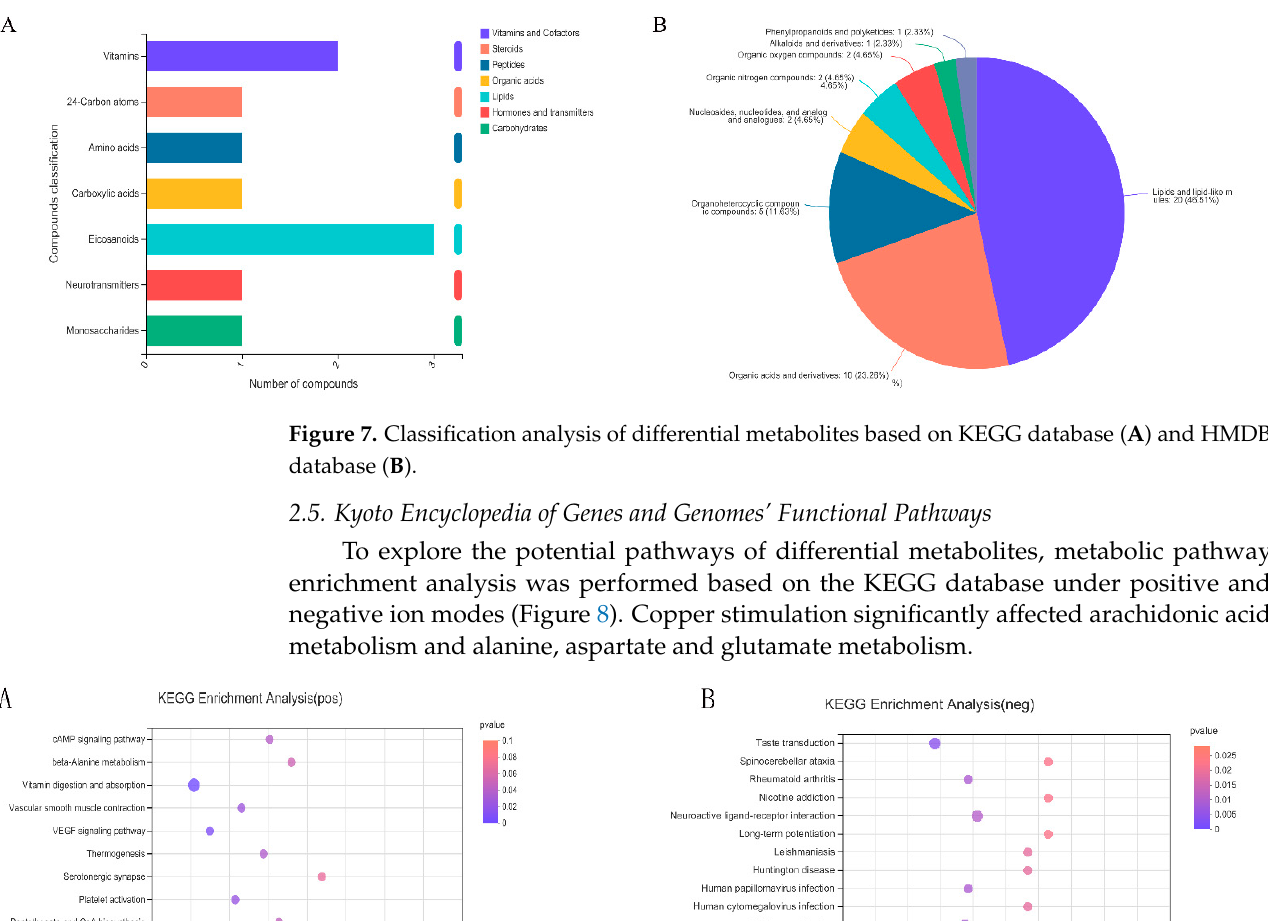
Figure 6. Heat maps of significantly different metabolites under positive ion mode ( A ) and negative ion mode ( B ), respectively ( n = 6). The color in the panel represents the relative levels of each me- tabolite: purple represents low levels, and red represents high levels. In maps, class ( A ) represented control samples and class ( B ) represented copper samples.